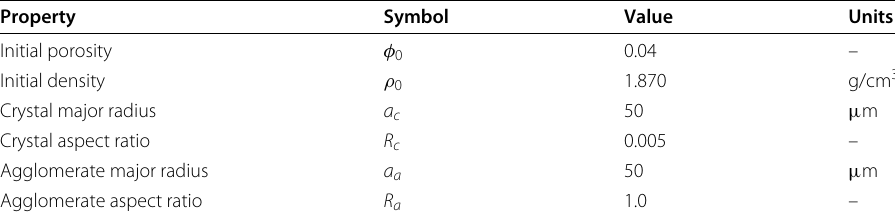
Table 2 Specimen material properties Property Symbol Value Units Initial porosity φ 0 0.04 – Initial density ρ 0 1.870 g/cm 3 Crystal major radius a c 50 µ m Crystal aspect ratio R c 0.005 – Agglomerate major radius a a 50 µ m Agglomerate aspect ratio R a